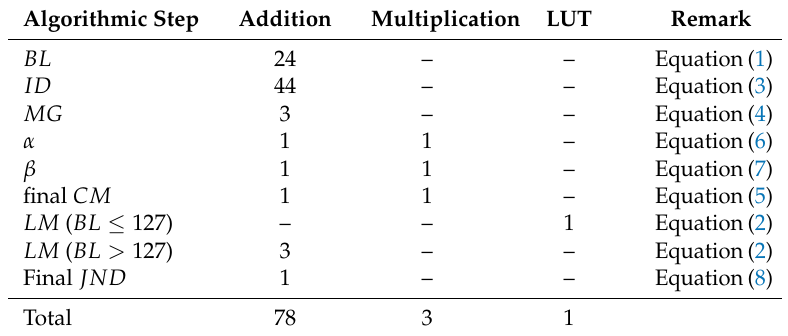
Table 3. Basic operations required for computing a visibility threshold by Chou and Li’s JND model.